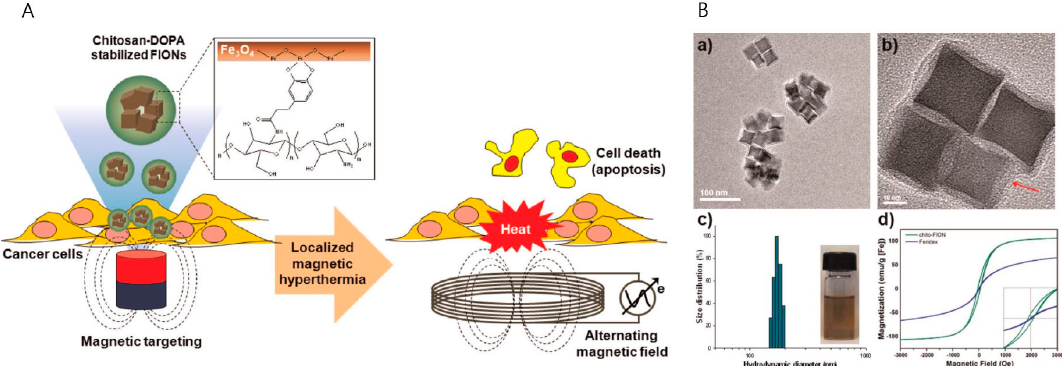
Figure 10. ( A ) Schematic diagram of ferrimagnetic iron oxide nanocube (FION)-loaded chitosan nanoparticles for hyperthermia of cancer cells; ( B ) TEM images and physicochemical characterizations of FION-loaded chitosan nanoparticles: ( a , b ) TEM images of FION-loaded chitosan nanoparticles (red arrow indicates the chitosan polymer coating layers); ( c ) hydrodynamic diameters of FION-loaded chitosan nanoparticles in phosphate-buffered saline; ( d ) magnetization curves of FION-loaded chitosan nanoparticles and Feridex ® (Adapted with permission from [82]. Copyright 2012 American Chemical Society).